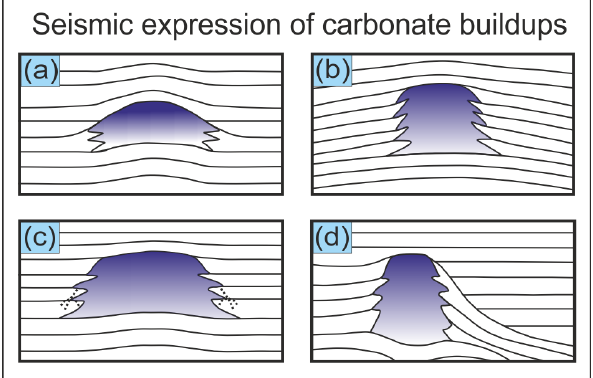
Figure 1. Common types of seismic expression of carbonate buildups used for their seismic identification and characteristics (based on Bubb and Hatlelid, 1977; Veeken and Van Moerkerken, 2013; modified): (a) velocity pull-up and differential compaction, (b) reflection-free with drape effect, (c) reflection-free with diffrac- tions on edge, and (d) compaction sag and transgressive onlap.